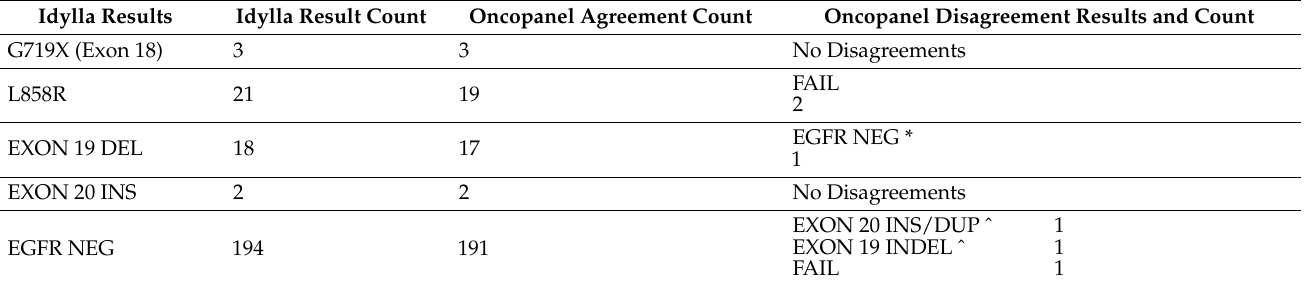
Table 1. Comparison of Idylla results to the standard Oncopanel NGS within the trial cohort. * Oncopanel did not report an EGFR exon 19 indel c.2236_2250delGAATTAAGAGAAGCA. The variant was present in NGS data at a VAF < 1% (below the LOD). ˆ Idylla did not detect the c.2317delinsTACAACCCCT (NGS VAF = 25.1%) as these variants are not specifically targeted by